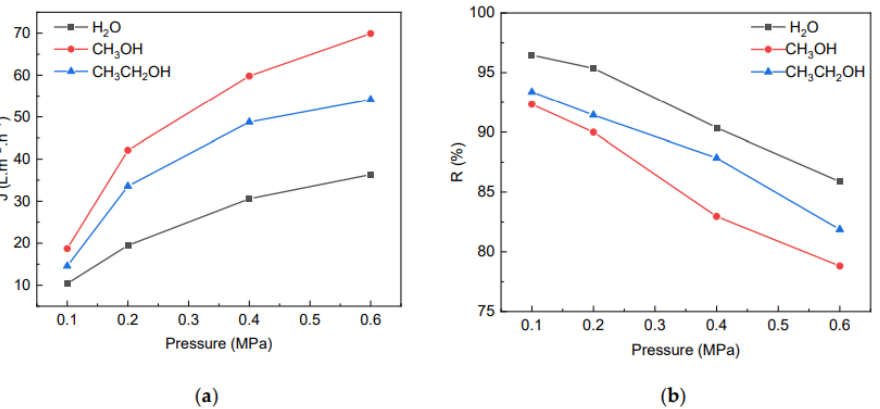
Figure 10. The effect of different coagulation bath on flux ( a ) of the membrane and rejection rate for BSA ( b ).